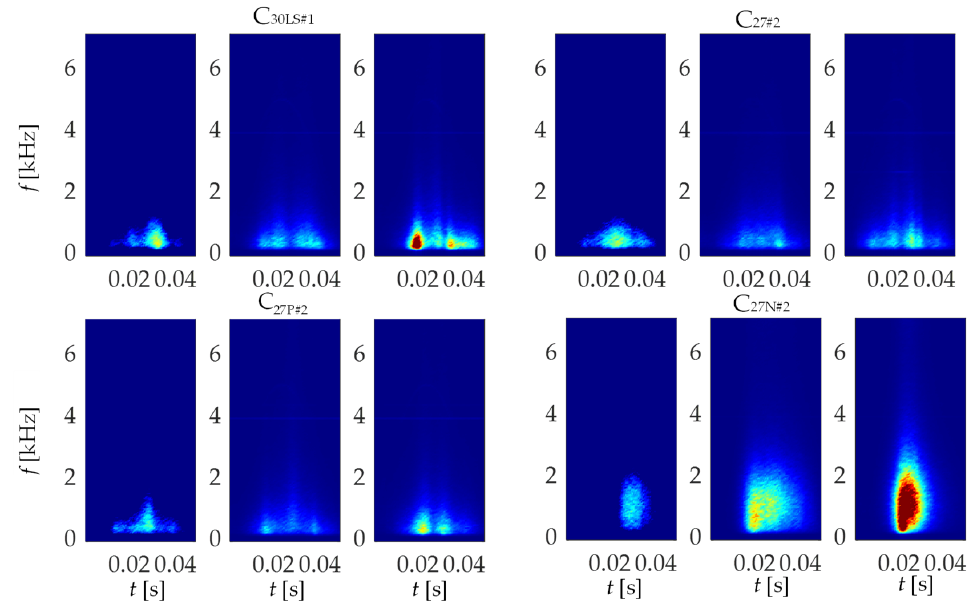
Figure 7. Selected amplitude of STFT spectrograms |S BN ( t, f )| 2 obtained for three different angles between magnetization direction and the TD direction.